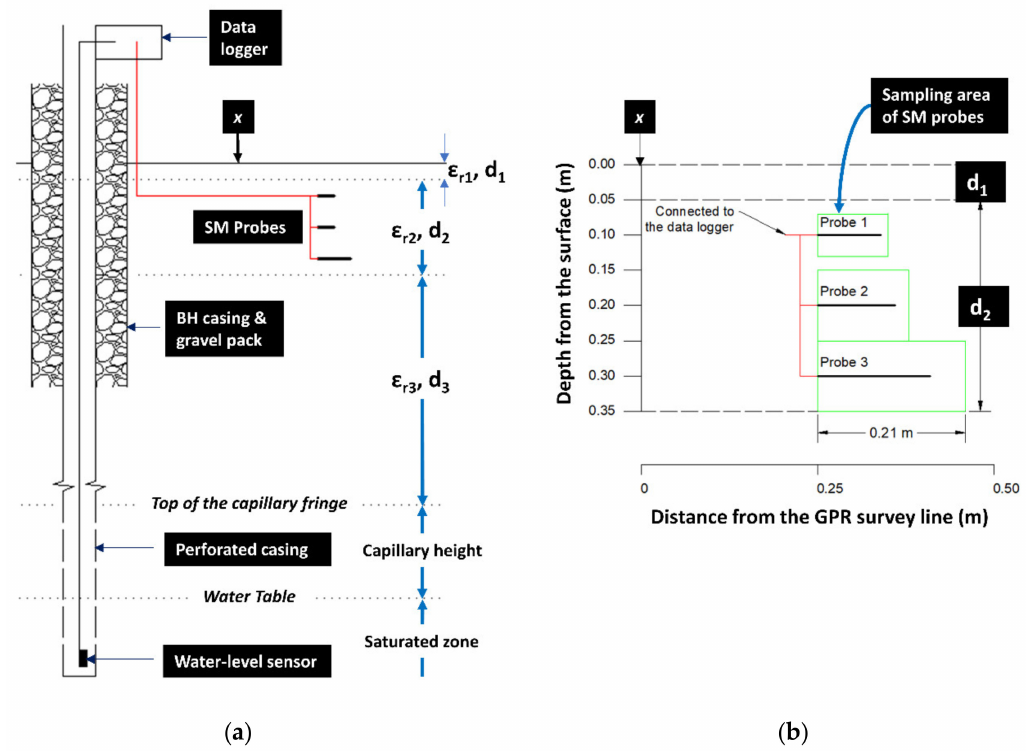
Figure 3. ( a ) A–A 1 vertical cross-sectional view of the soil profile and the details of the borehole (BH). ( b ) The sampling areas of soil moisture (SM) probes. “ x ” marks the position of the ground penetrating radar (GPR) survey